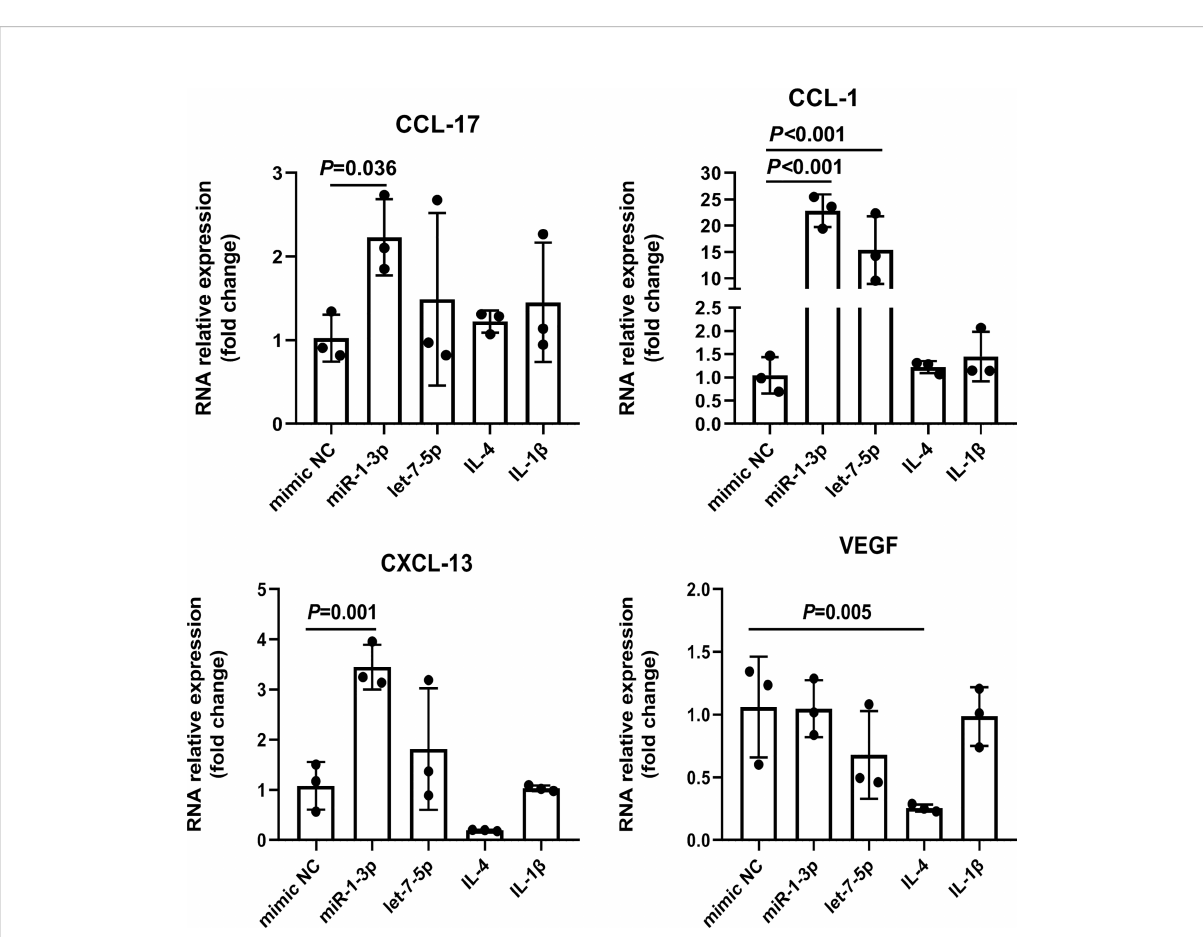
FIGURE 6 miR-1-3p mimic (50 nM) and let-7-5p mimic (50 nM) were used to stimulate mouse BMDMs, and the M2-type macrophage subtype marker factors were analyzed using qRT-PCR, using IL-4 (M2a) and IL1 b (M2b) as positive controls. The housekeeping gene GAPDH was used as an internal